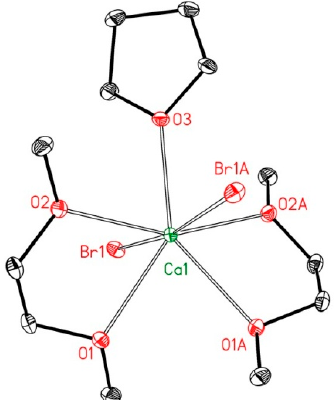
Figure 5. Molecular structure and atom numbering scheme of [(dme) 2 (thf)CaBr 2 ] ( 4 ). Symmetry related atoms are marked with the letter “A”. The ellipsoids represent a probability of 30%; H atoms are neglected for clarity reasons. Selected bond lengths (pm): Ca1–Br1 288.86(2), Ca1–O1 249.0(1),